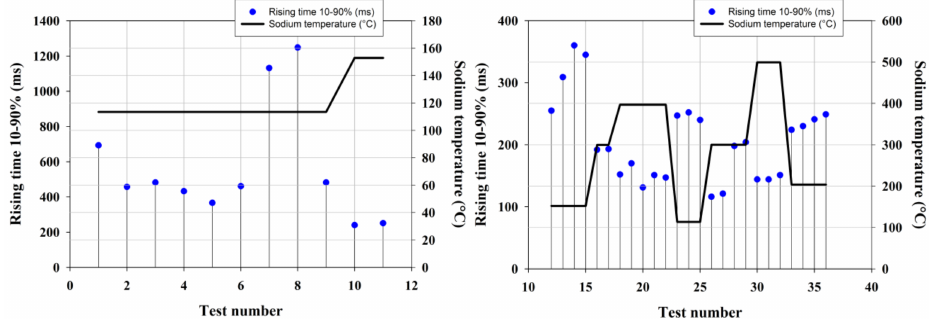
Figure 15. Analysis of regenerated FBG-based optical fiber temperature probe response time during immersion in liquid sodium heated at different